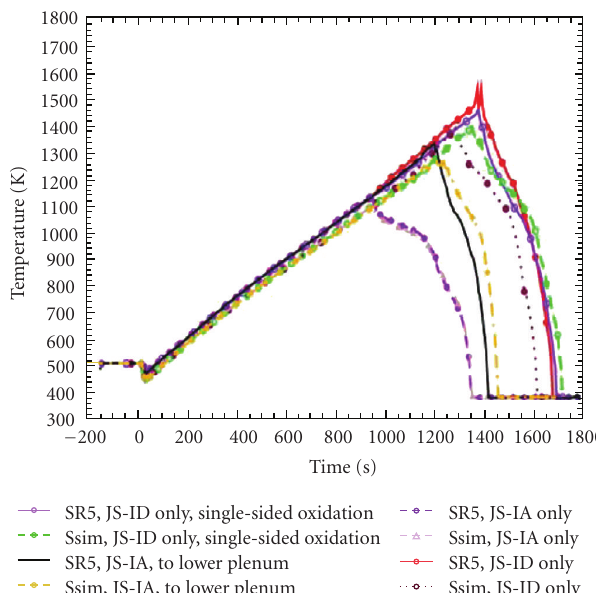
Figure 10: Example of RELAP/SCDAPSIM and SCDAP/RELAP5 Beznau-calculated results for peak cladding temperature for a range of safety injection